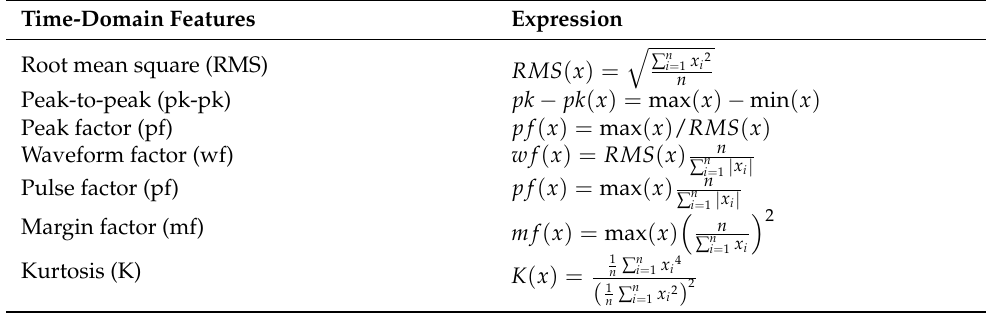
Table 1. Several time-domain features